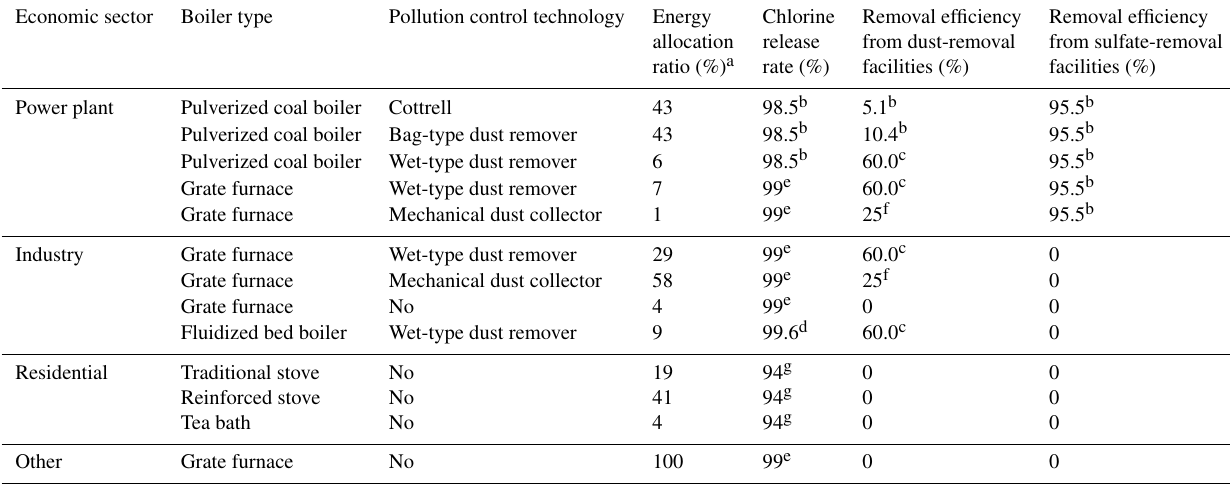
Table 2. Emission factors of chlorine from coal combustion in China. Economic